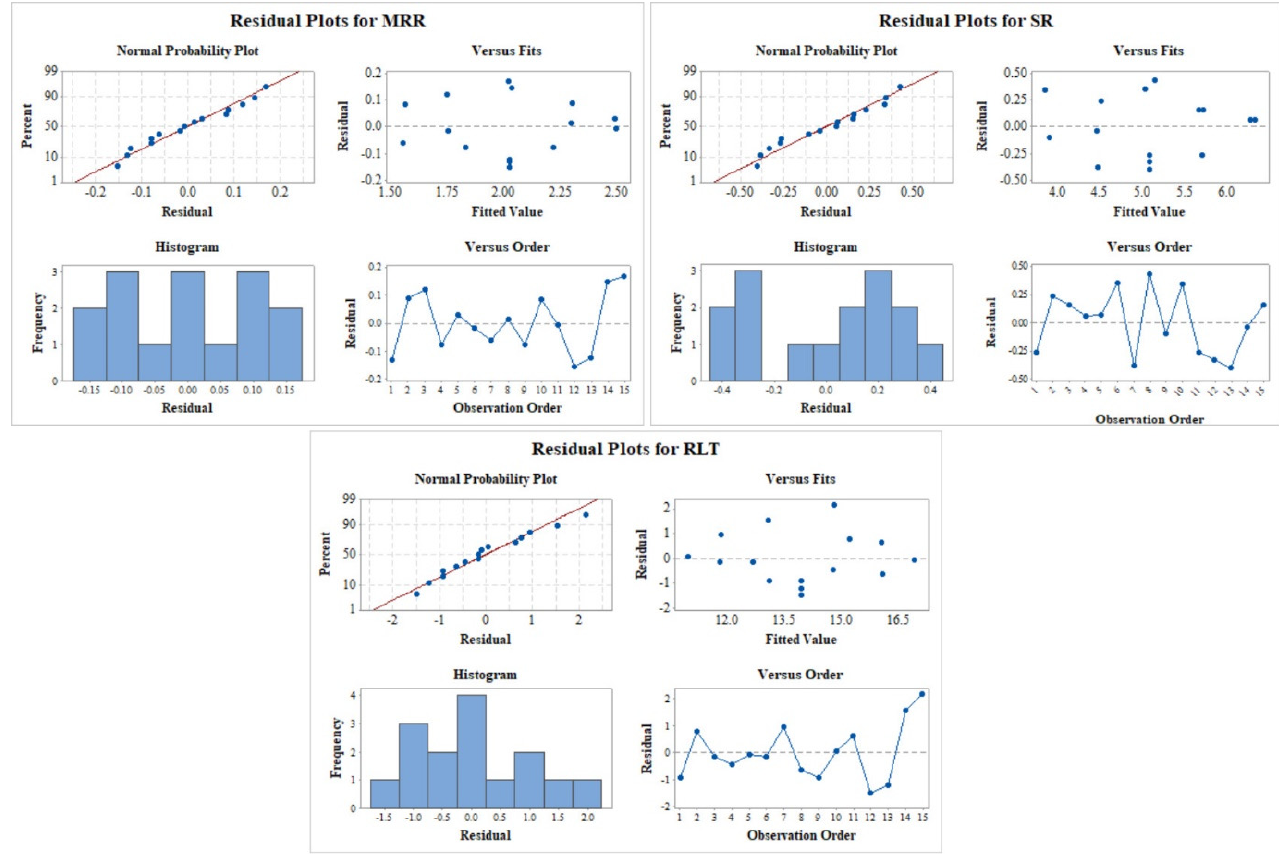
Figure 4. Residual plot for MRR, SR, and RLT.